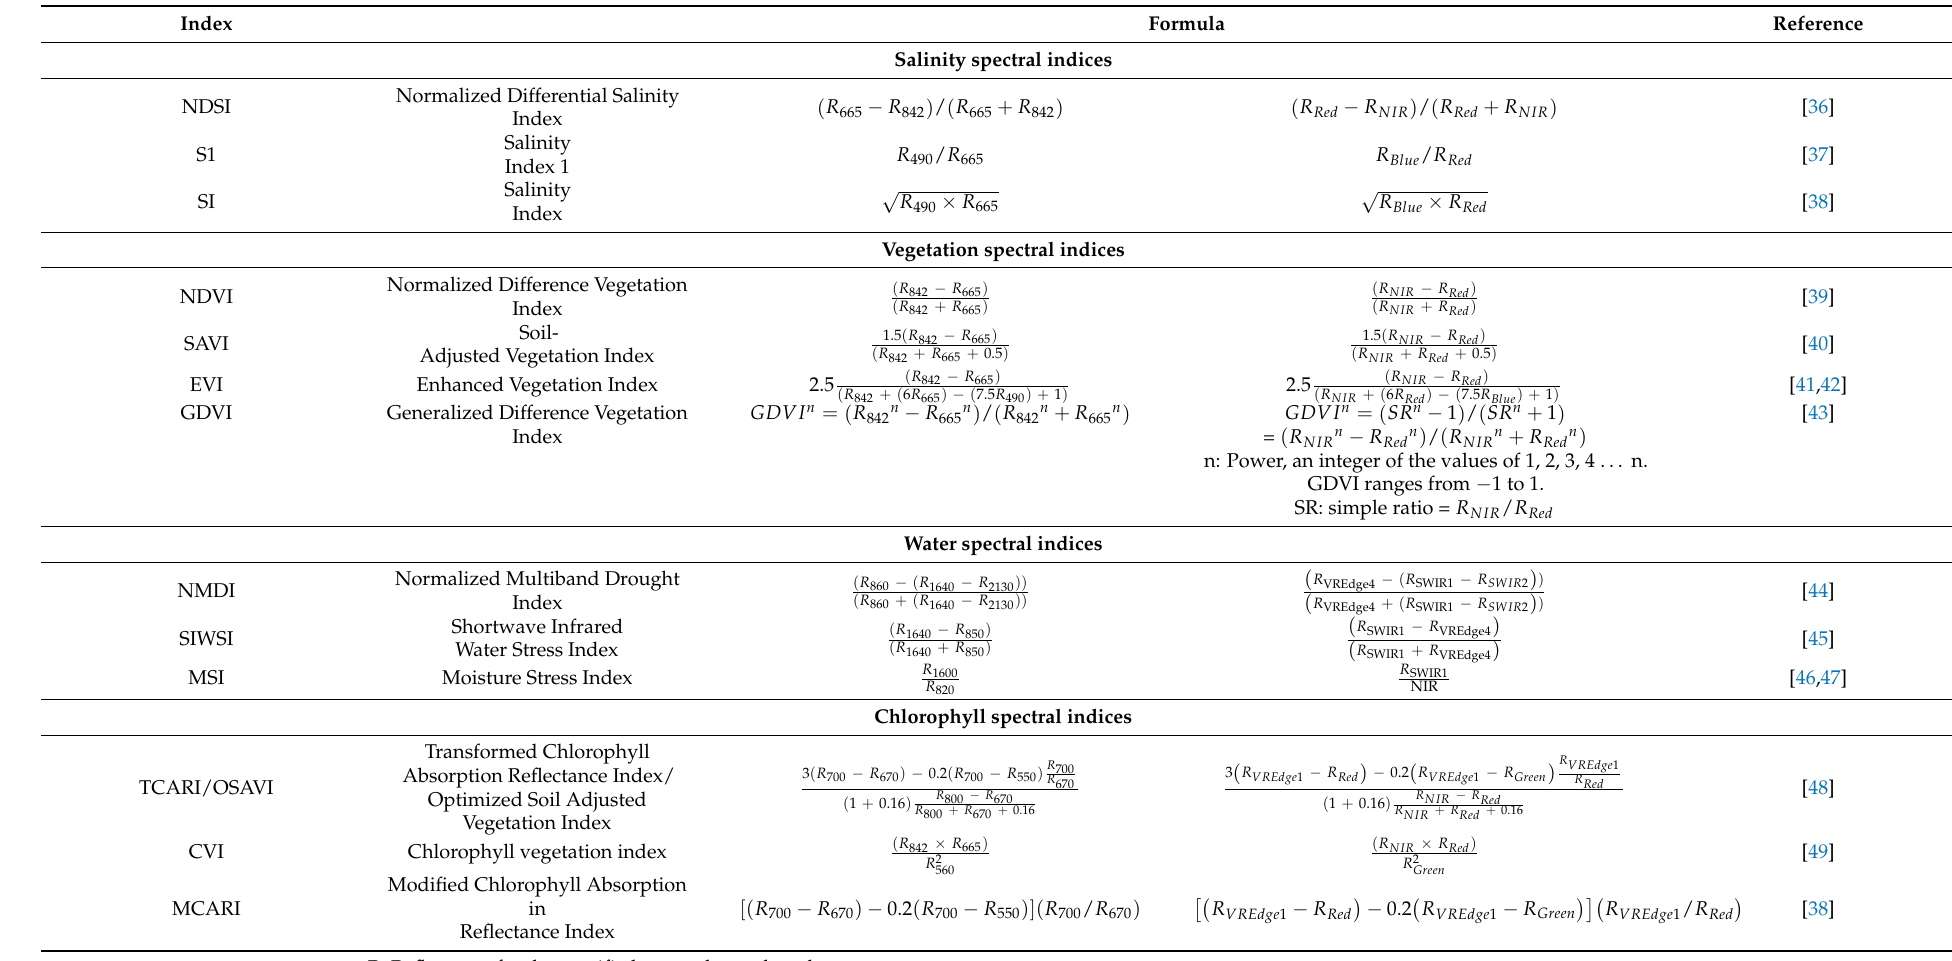
Table 4. List of selected spectral indices related to salinity